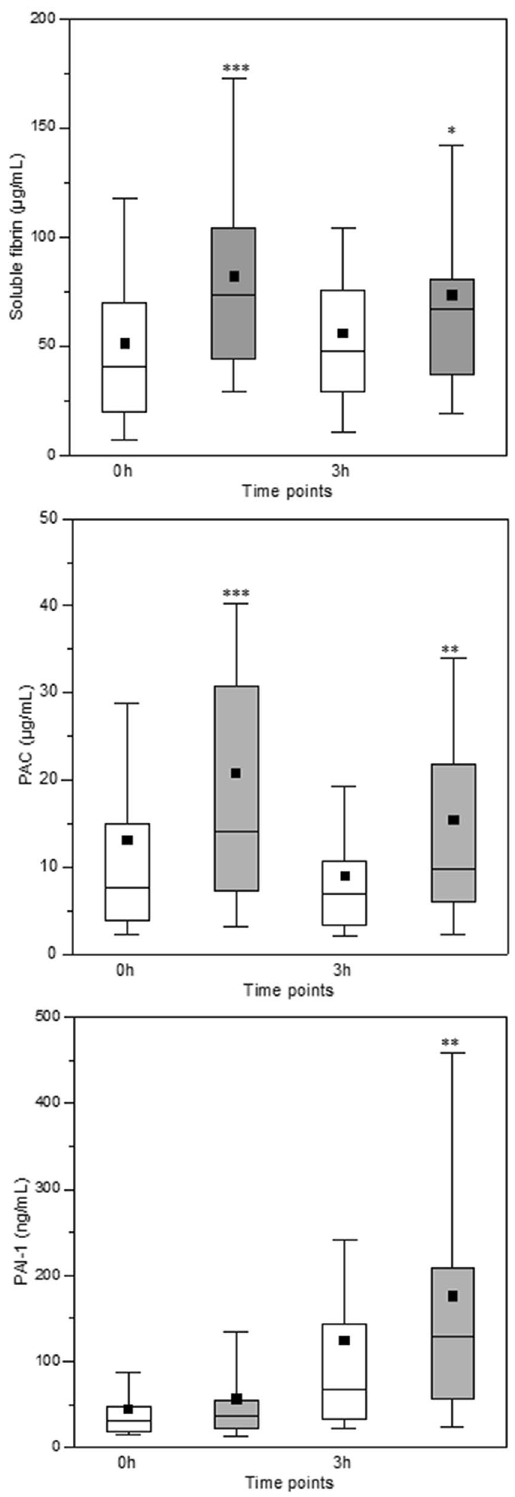
Figure 3. Box plots for soluble fibrin, plasmin and antiplasmin complex (PAC), and plasminogen activator inhibitor-1 (PAI-1) at 0 and 3 h after presentation to the emergency department. Disseminated intravascular coagulation (DIC) patients showed significantly higher values of soluble fibrin and PAC at 0 and 3 h and PAI-1 at 3 h than did non-DIC patients. White box, non-DIC patients; grey box, DIC patients. Horizontal bars in the box indicate the median (middle) and interquartile ranges (upper 25% and lower 75%). Black boxes are mean values. * P < 0.05, ** P < 0.01, *** P < 0.001 versus non-DIC